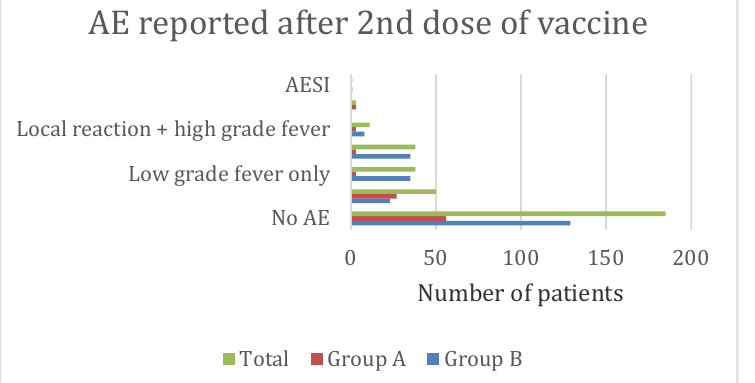
Figure 3. Adverse events (AE) reported following second dose of Pfizer-BioNTech’s m-RNA COVID-19 vaccine in Indian children 5–11 years of age (group A, n = 95) and 12–17 years of age (group B, n = 230). p < 0.001 between the groups on Chi-square test.